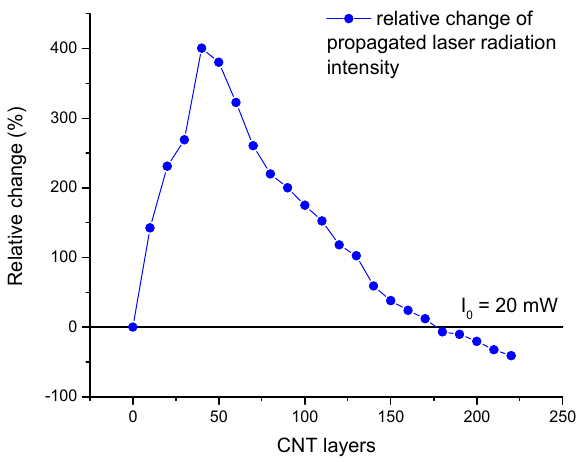
Figure 5. Relative change of laser radiation intensity during the CNT deposition process.